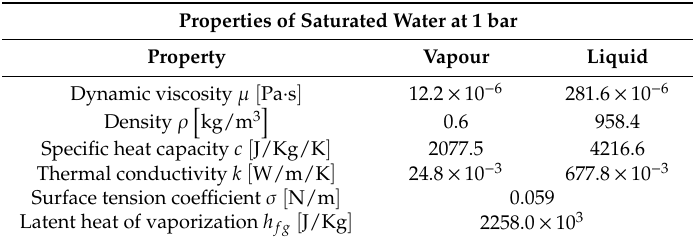
Table 1. Properties of saturated water at 373.15K and 1